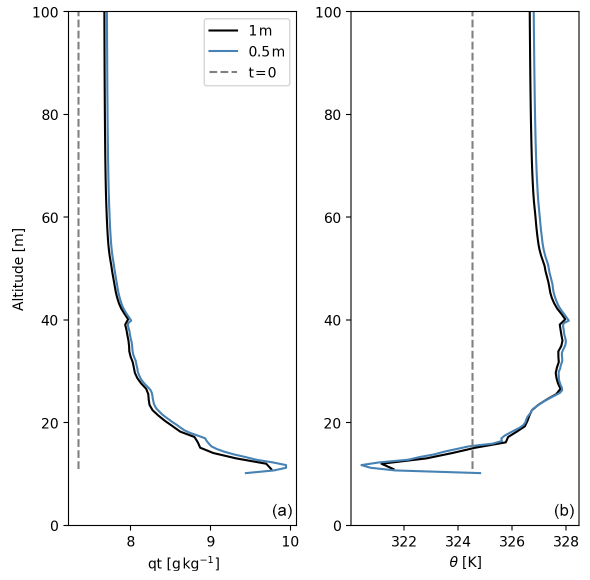
Figure A2. Total specific humidity (a) potential temperature (b) profiles for the real experiment with d x = 1m (black), d x = 0.5m (blue) averaged over the simulation hour and their initial profiles at t = 0 (grey).